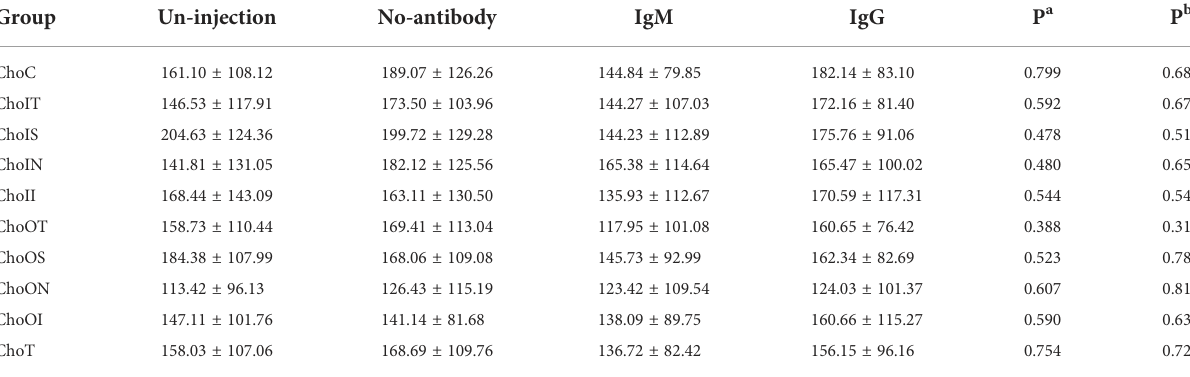
TABLE 2 Analysis of choroidal thickness in the age-related cataract patients with different COVID-19 antibody statues (median ± IQR, m m).